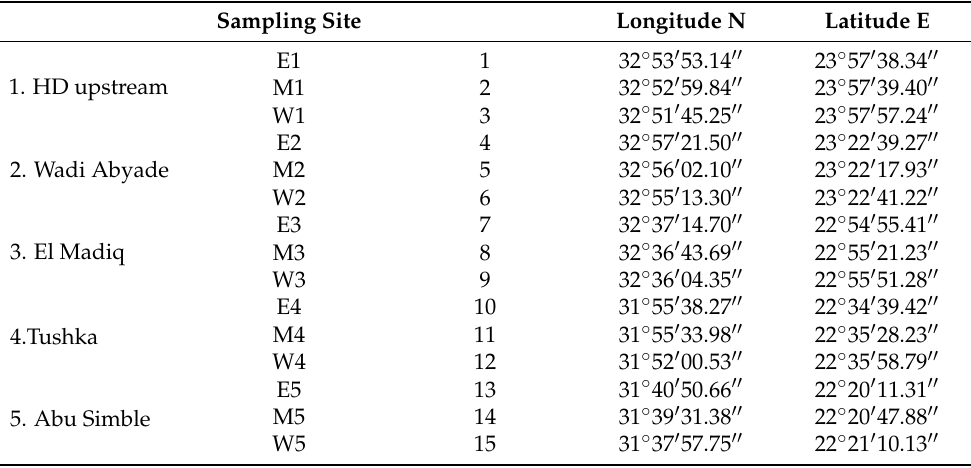
Table 1. Geographical coordinates of the sampling sites in Lake Nasser. Sampling Site Longitude N Latitude